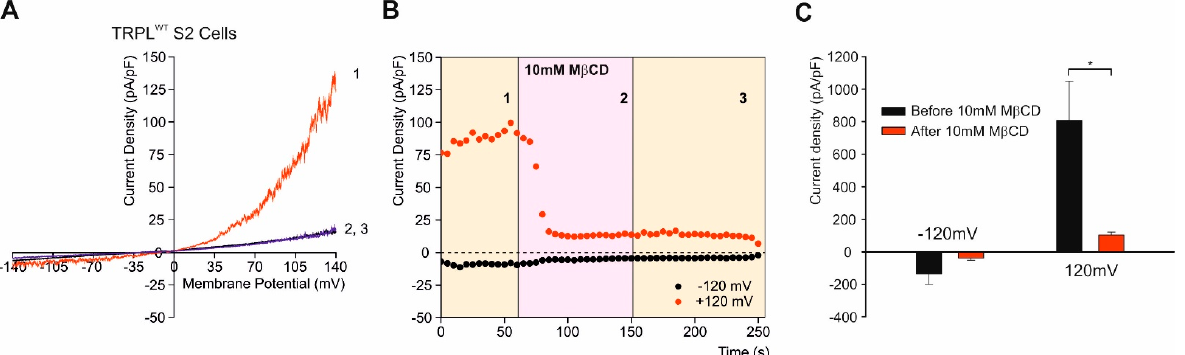
Figure 6. Sequestration of cholesterol abolished the constitutive activity of TRPL channels. ( A ) Current–voltage relationships (I–V curves) measuring TRPL-dependent currents I–V curves obtained in response to voltage ramp (of 1 s duration) from S2 cells expressing TRPL and showing basal channel activity with strong outward rectification, typical for TRPL-dependent current (1). The TRPL channel activity was highly reduced after perfusion with 10 mM M β CD (2) and the effect was irreversible, even after washout of M β CD (3) ( n > 10). ( B ) Time course of the M β CD effects on TRPL currents in S2 cells. Current densities are shown as a function of time. Series of I–V curves were derived from repeatedly applied voltage ramps every 5 s and currents were measured at ± 120 mV holding potentials as a function of time under the various experimental conditions as indicated. The numbers correspond to the numbers on the I–V curves in ( A ). ( C ) Statistics of the cholesterol depletion experiments in S2 cells. Cholesterol depletion by M β CD had a significant effect on the positive TRPL currents at 120 mV ( n = 5, values are average ± SEM, paired Student t -test, * p ≤ 0.05). (From [121] ).